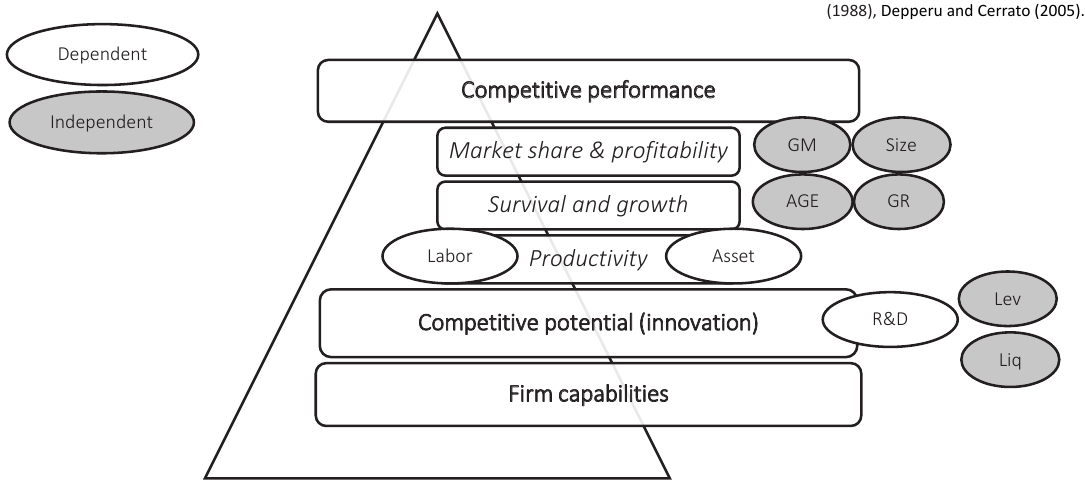
Figure 1. Competitiveness dimensions and the way to assess